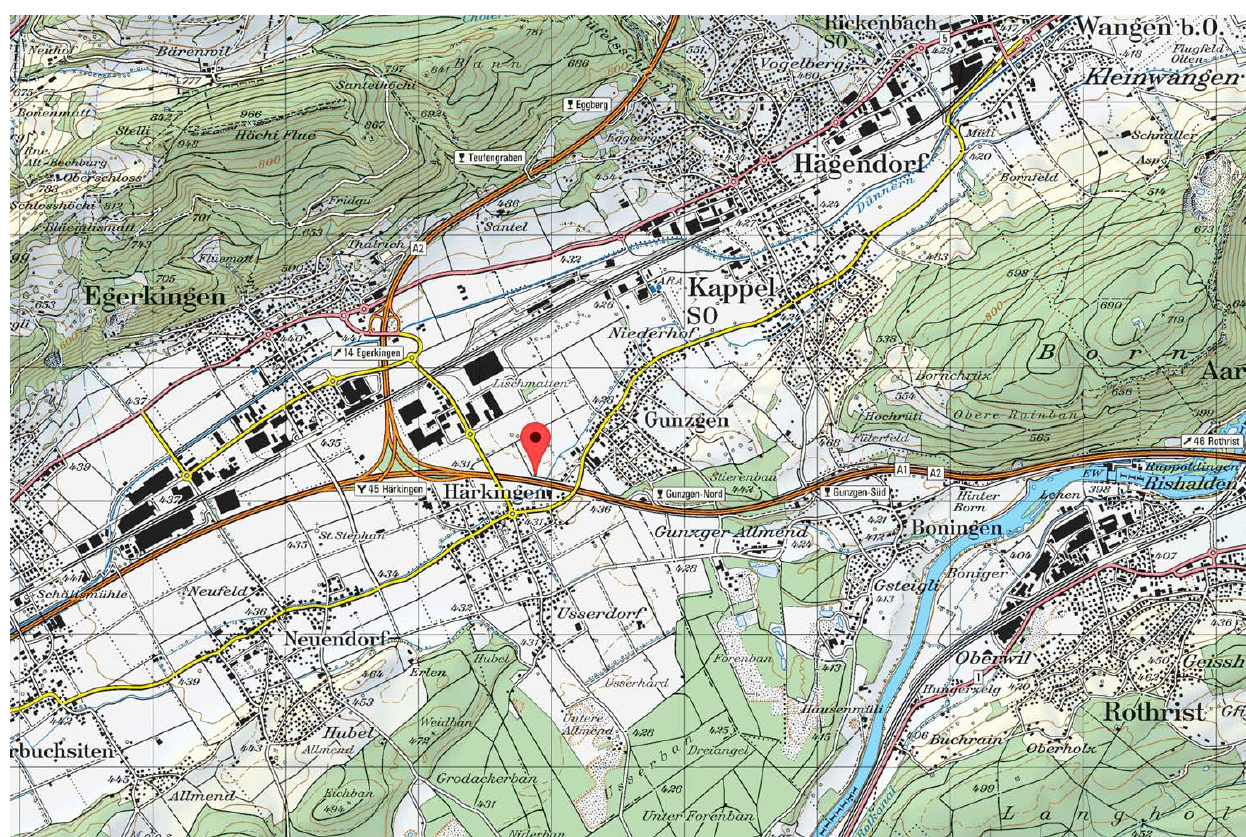
Figure 1. Map of the sampling location (NABEL site in Härkingen). The site is marked with the red Google pin. Map reproduced by permission of swisstopo